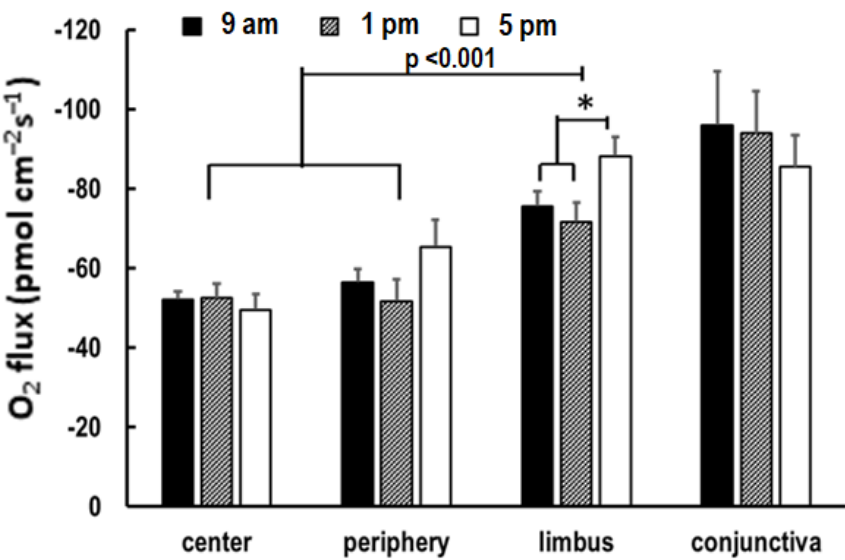
Figure 6. O 2 uptake at the limbus measured in in vivo cornea showed a significant increase (*: p < 0.05) compared to the measurements at 9 am and 1 pm. Data are expressed as mean ± S.E.M.